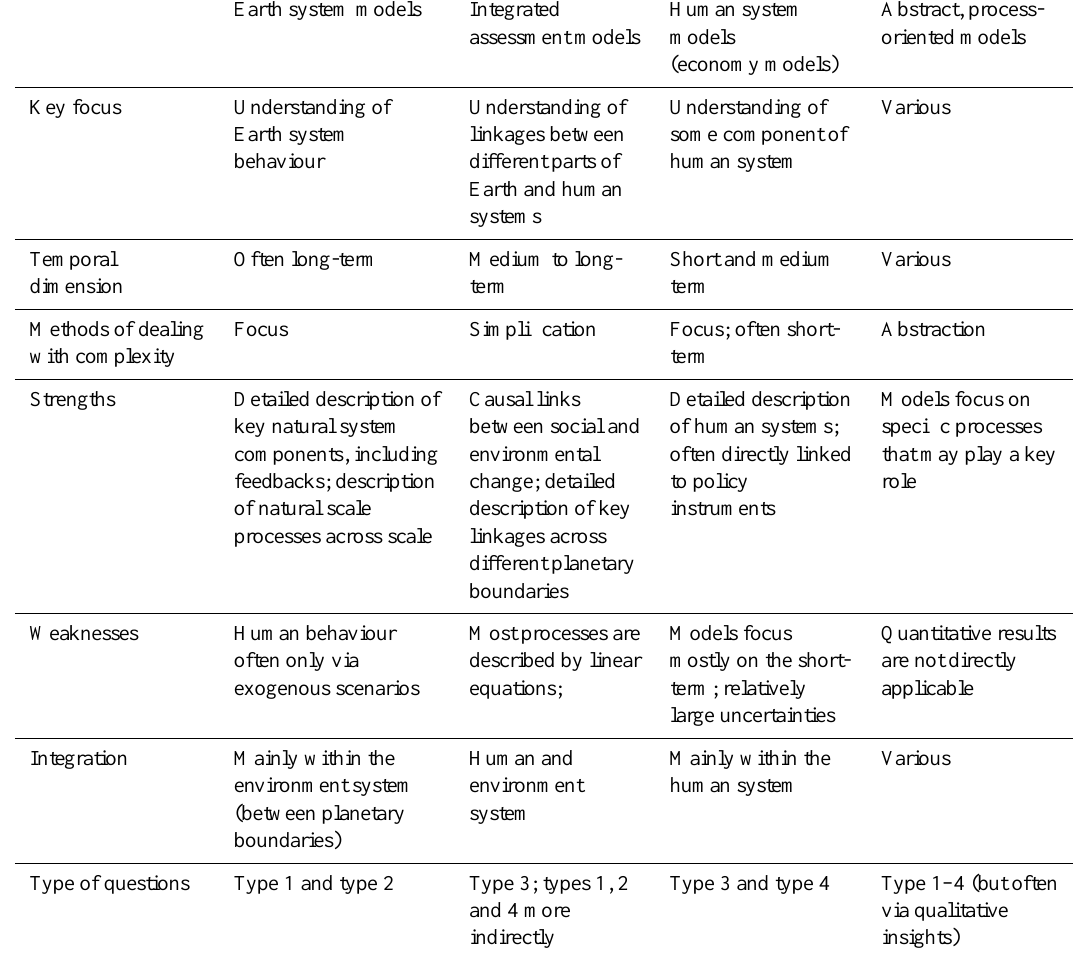
Table 2. Different categories of models for planetary-boundary-related